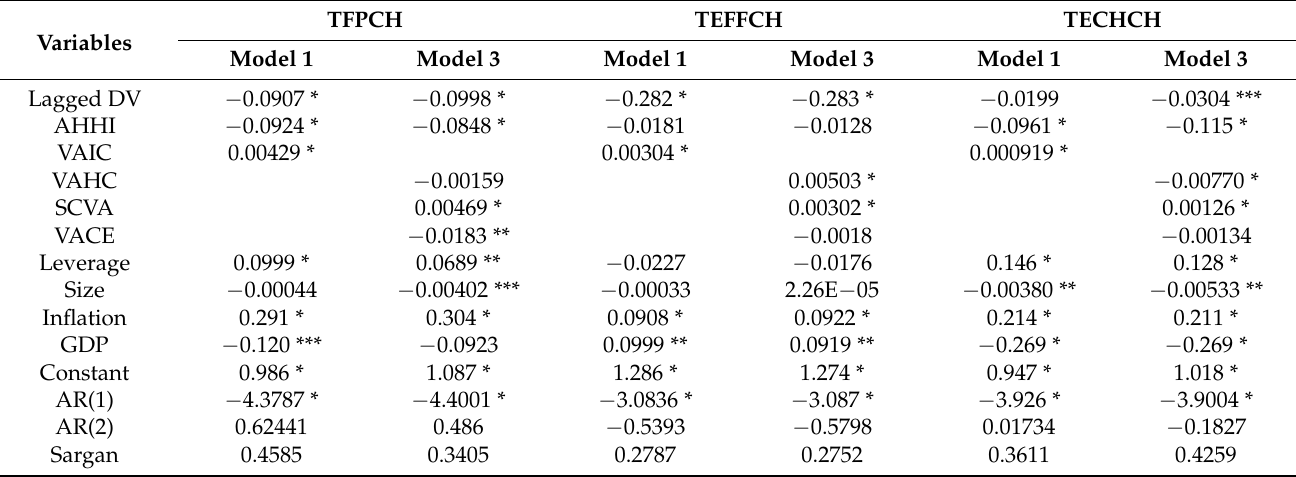
Table 4. Productivity—Intellectual Capital Nexus (VAIC™).